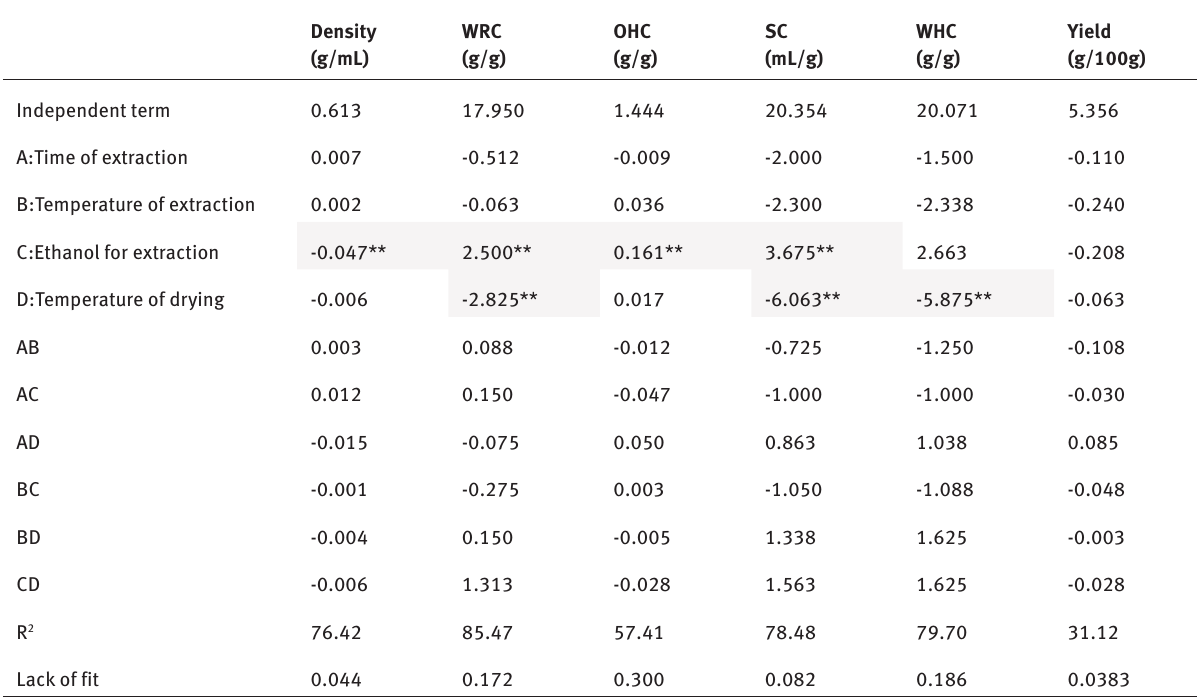
Table 4: Coefficients of regression and ANOVA for properties of DF obtained with microwave